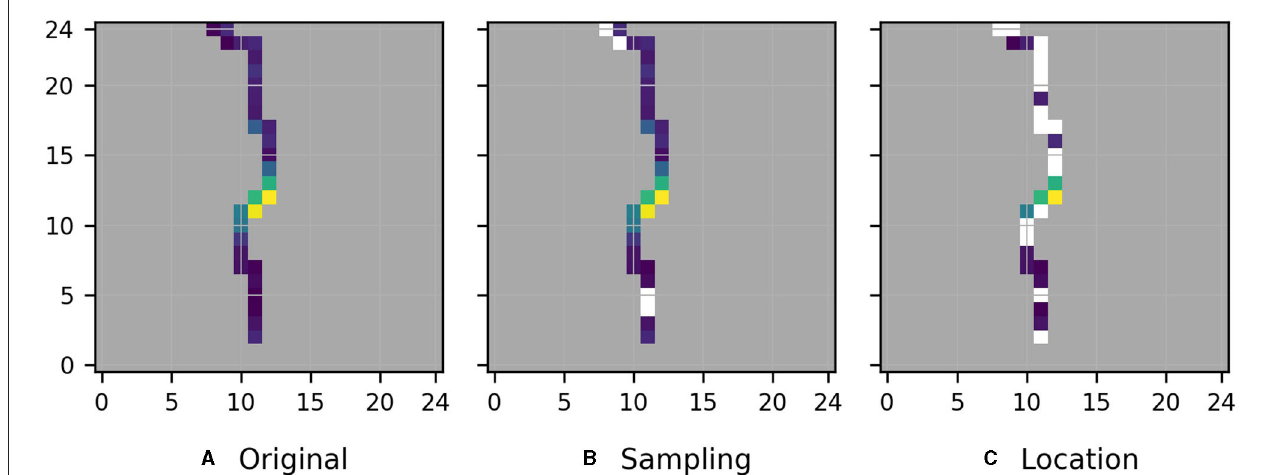
FIGURE 7 | (A) Description E d of the function that the MLP learned when it was trained on the original water level prediction task (see Figure 1B ). The description is a measure of the average importance of each pixel in the considered river segment for the predictions of the model. Yellow color indicates high and blue color low importance. (B,C) As (A) , but pixels for which the relative distance between the original description E d and one of the sampling and (shifted) location variant descriptions E d v i , respectively, exceeds the threshold of t = 0.5, are masked. Gray marks pixels outside the considered river segment.